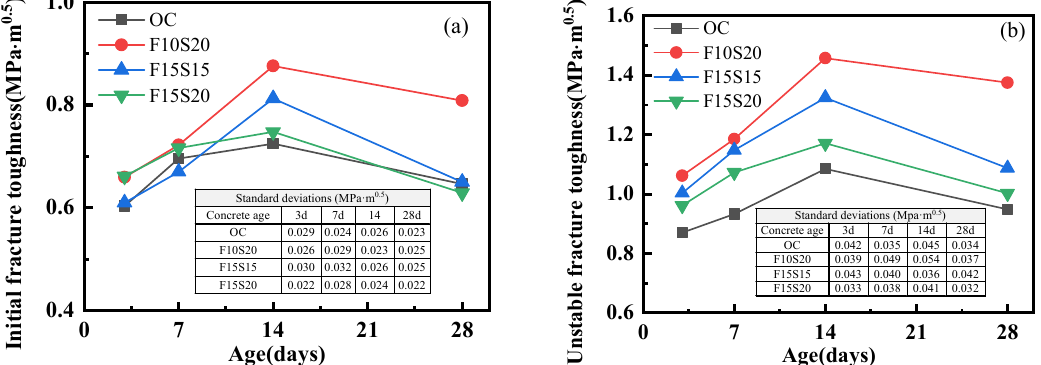
Figure 6. Variation of fracture toughness of concrete with curing age: ( a ) Initial fracture toughness; ( b ) Unstable fracture toughness.